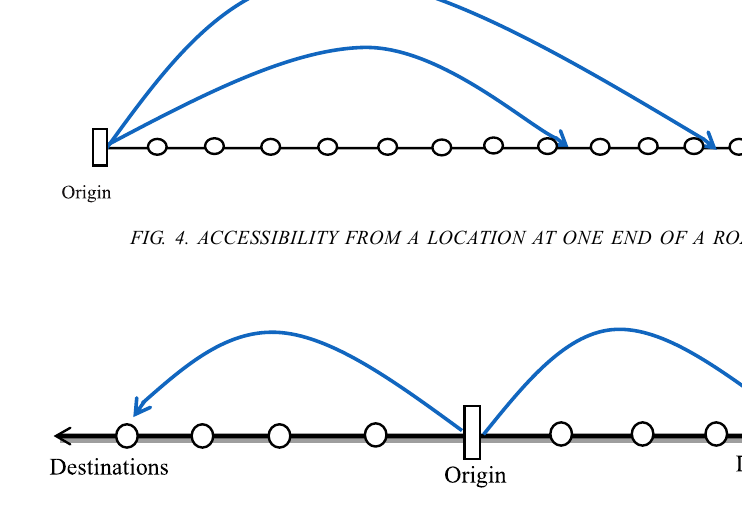
FIG. 5. ACCESSIBILITY FROM A LOCATION IN THE CENTER OF A ROADWAY